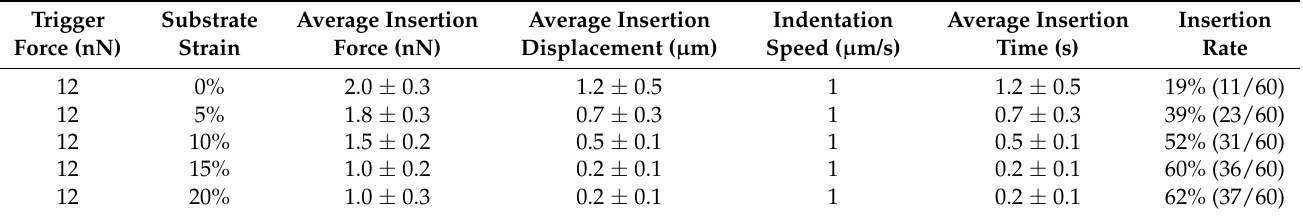
Table 1. The statistical analysis of the insertion behaviors under different substrate strain states.